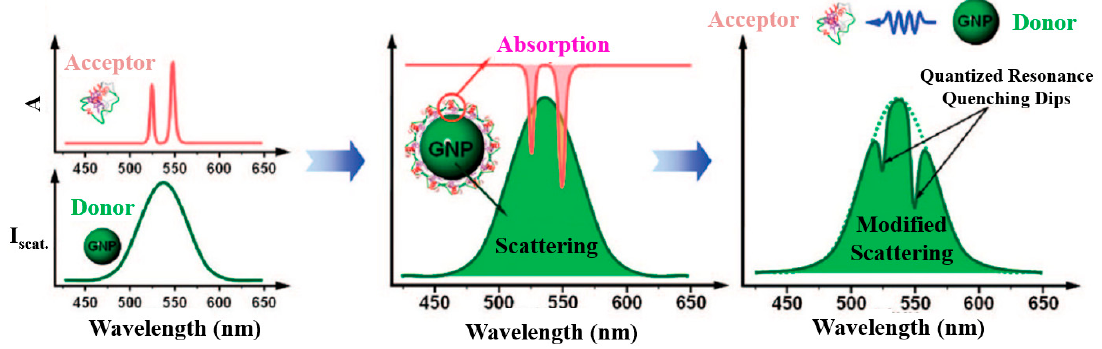
Figure 25. PIRET-based molecular imaging systems [102].